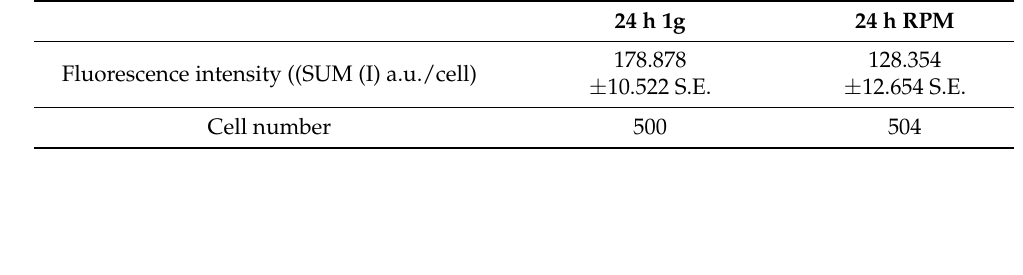
Table 1. Quantitative analysis of fluorescence intensity of E-cadherin. Fluorescence intensity (SUM (I), a.u arbitrary units) was evaluated in about 500 cells. (S.E. Standard Error; 24 h 1g vs24 h RPM p < 0.01 valuated by Student’s t -test).